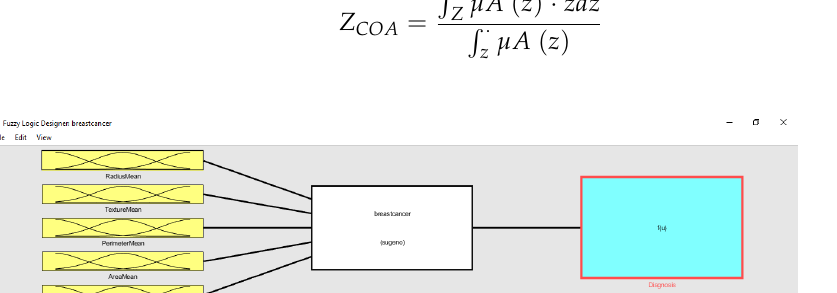
. Figure 23. Diagnosis for severe cases.